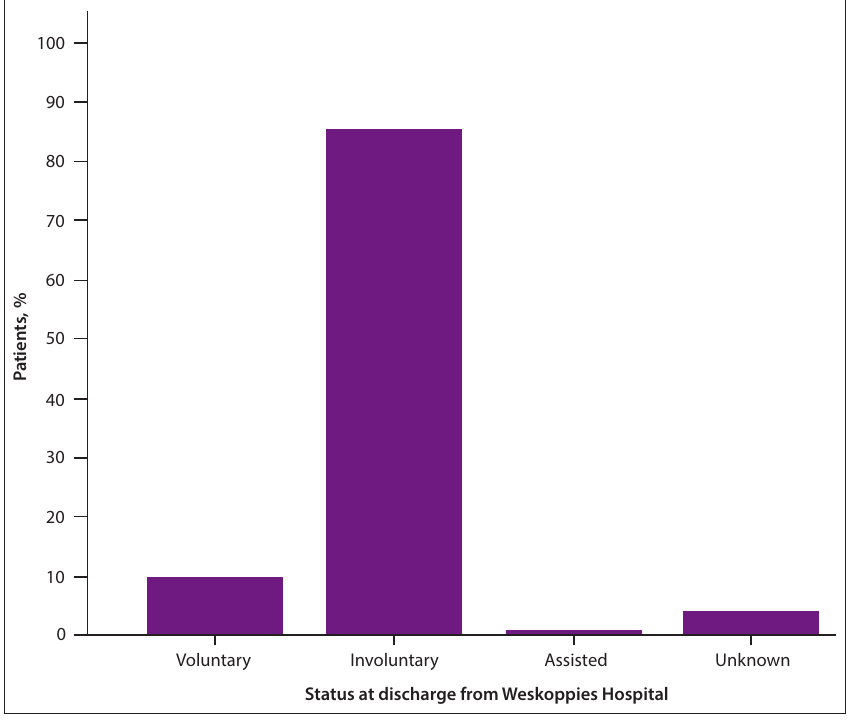
Fig. 2. Number of patients and status at discharge.